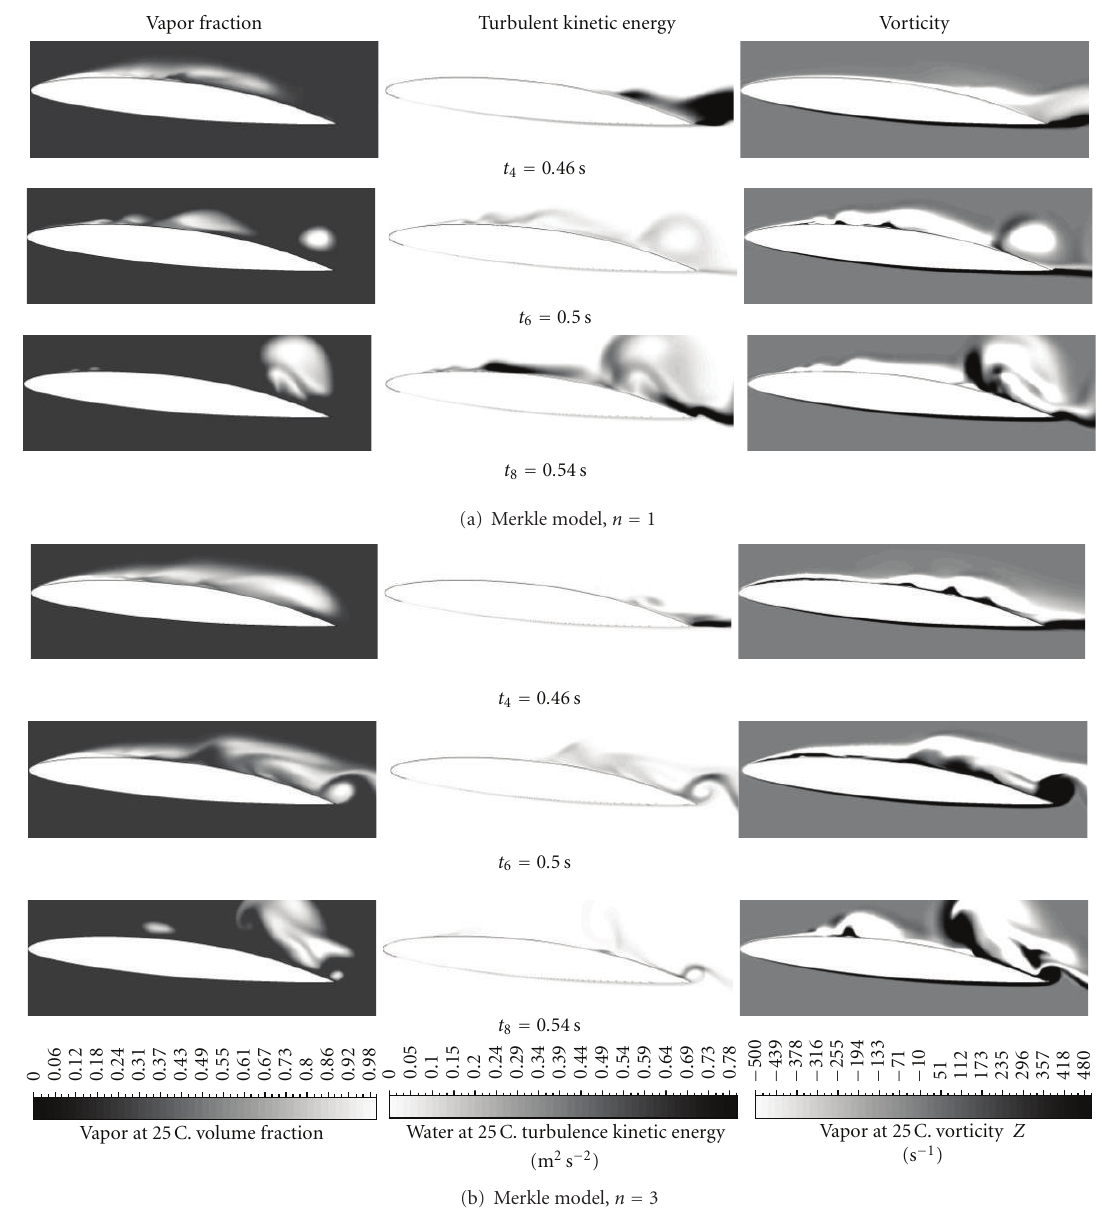
Figure 10: Comparison of the vapor fraction (left), turbulent kinetic energy (middle), and vorticity (right) contours for the Merkle cavitation models with (a) n = 1 and (b) n = 3, in the case of unsteady sheet/cloud cavitation with σ = 1 . 00, Re = 750,000, V ∞ = 5m/s, and α = 6 ◦